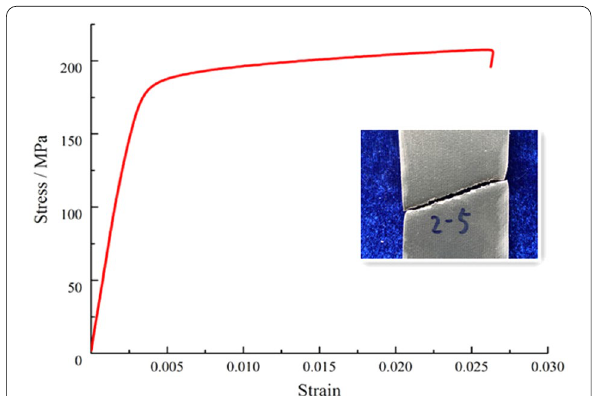
Fig. 2 Stress–strain relationship of